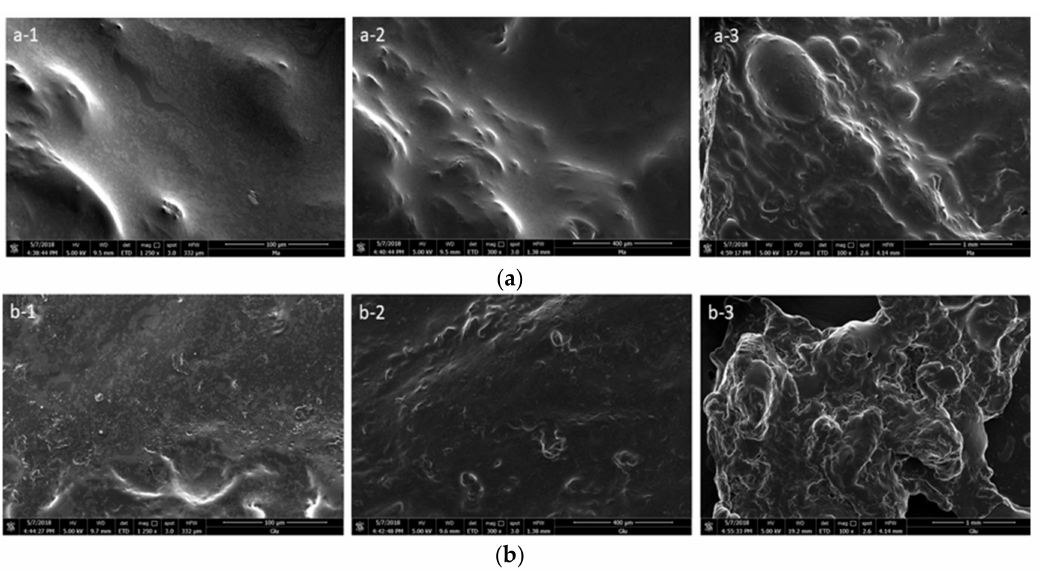
Figure 3. ( a ) Electron images of pectin extracted by ChCl–Mal; a-1 (1250 × ), a-2 ( 300 × ) a-3 (100 × ). ( b ) Electron images of pectin extracted by ChCl–Glc–W; b-1 (1250 × ), b-2 ( 300 × ) b-3 (100 ×